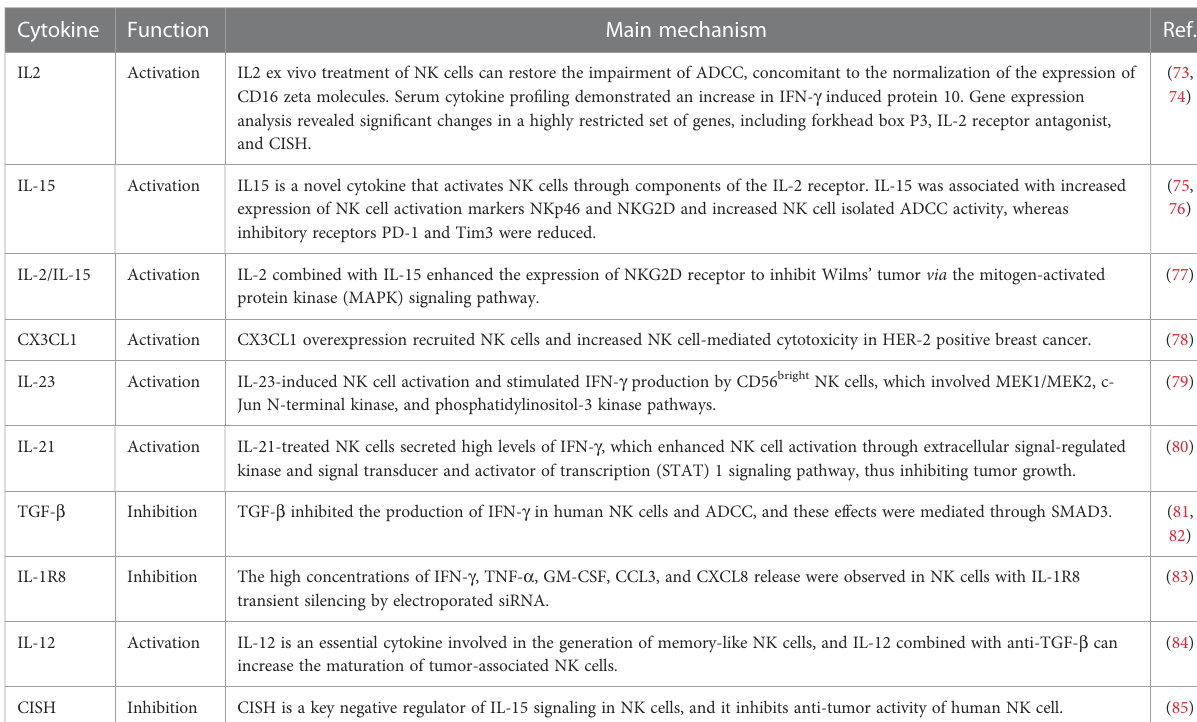
TABLE 1 Effect of cytokines on NK cells and ADCC effects. Cytokine Function Main